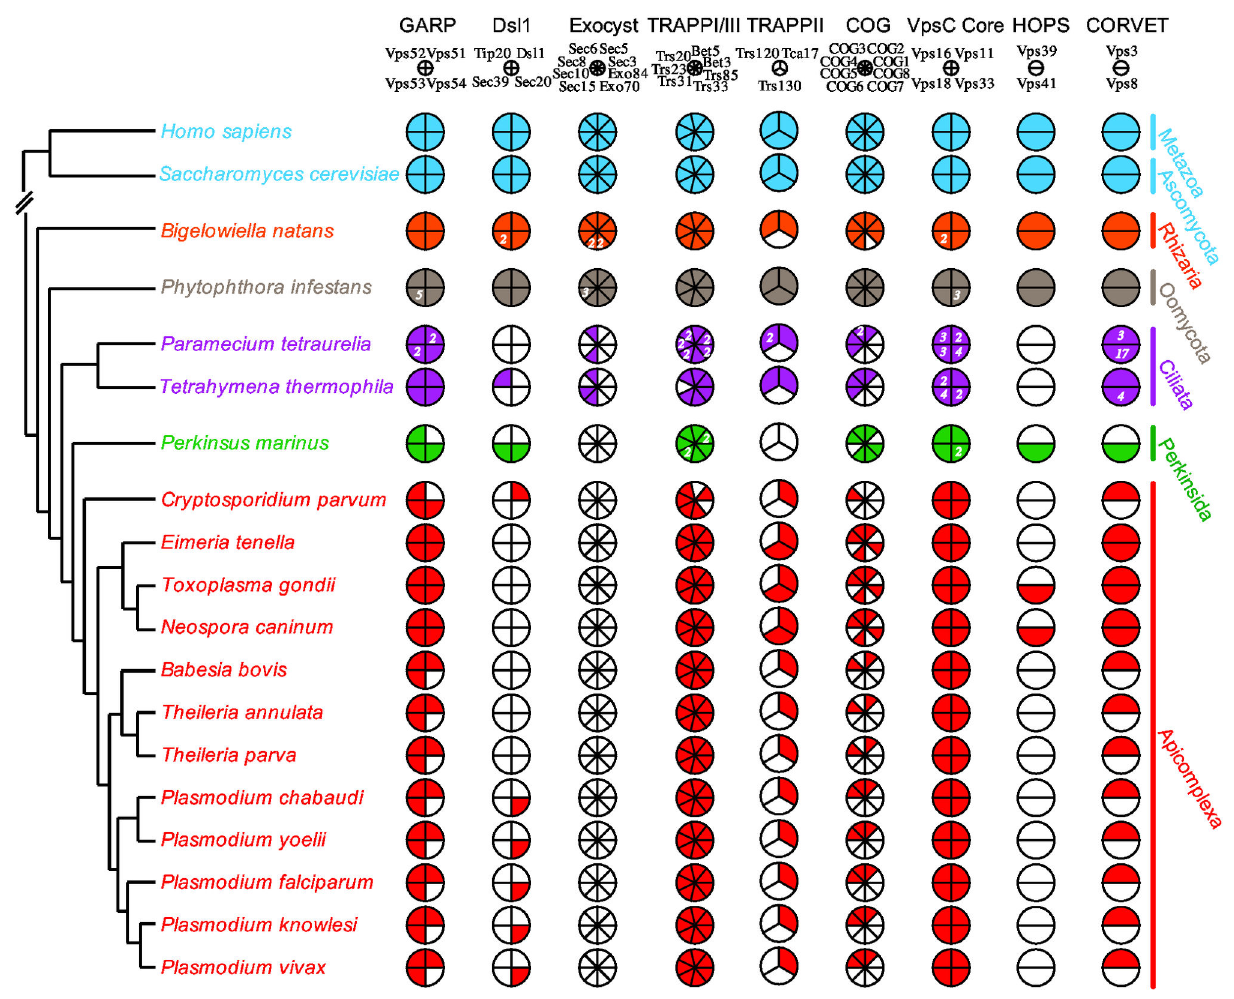
Figure 4. Comparative genomic survey of the eight MTCs across apicomplexans and select outgroups. This figure illustrates the sculpting of the MTC complement in alveolates and particularly in Apicomplexa across nearly all complexes. Coulson plot is read identically to Figure 1, and numbers in filled circles represent number of paralogues where appropriate. Colour-coding is not related to that found in Figure 1. The relationship between taxa are shown to the side, based on [114]. doi: